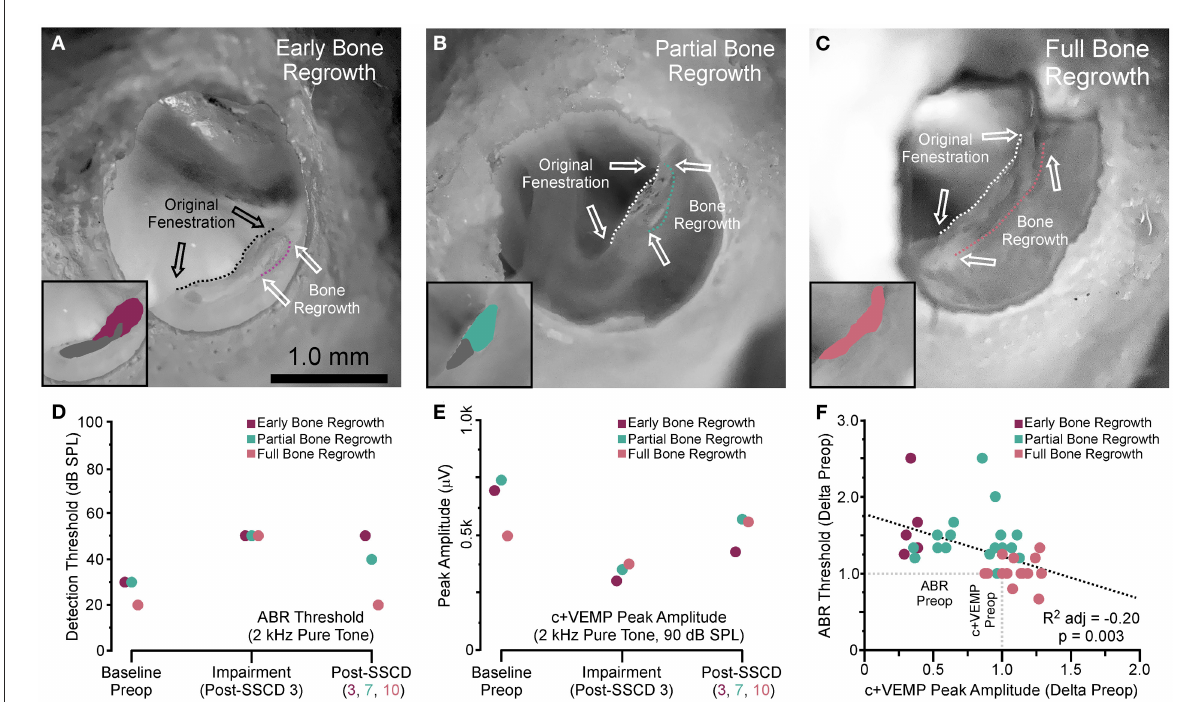
FIGURE5 Photomicrograph correlation between ABR and c + VEMP thresholds/amplitudes at experimental endpoints and indicators of bone regrowth. (A) Photomicrograph showing early bone regrowth 3 days after SSCD. (B) Photomicrograph showing partial bone regrowth 7 days after SSCD. (C) Photomicrograph showing full bone regrowth 10 days after SSCD. (D) Chart showing the changes to ABR thresholds at 2kHz for the animals shown in (A–C) at baseline, 3 days post-SSCD (impairment), and at the experimental endpoint (post-SSCD days 5–10). (E) Chart showing the changes to c + VEMP peak amplitudes at 90 dB SPL for the animals shown in (A–C) at baseline, 3 days post-SSCD (impairment), and at the experimental endpoint (post-SSCD days 5–10). (F) Scatterplot showing a negative correlation between ABR and c + VEMP based on bone regrowth